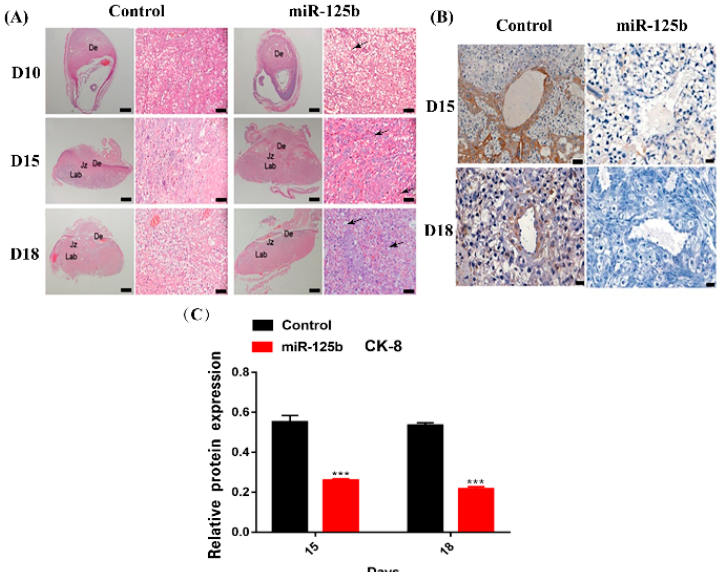
Figure 3. HE and CK-8 immunohistochemistry (IHC) staining of placenta ( A ): HE staining of the placenta of miR-125b group and control group on day 10, 15, and 18, the arrows showing the laby- rinth; ( B ): CK-8 IHC staining of the placenta miR-125b group and control group on day 15 and 18